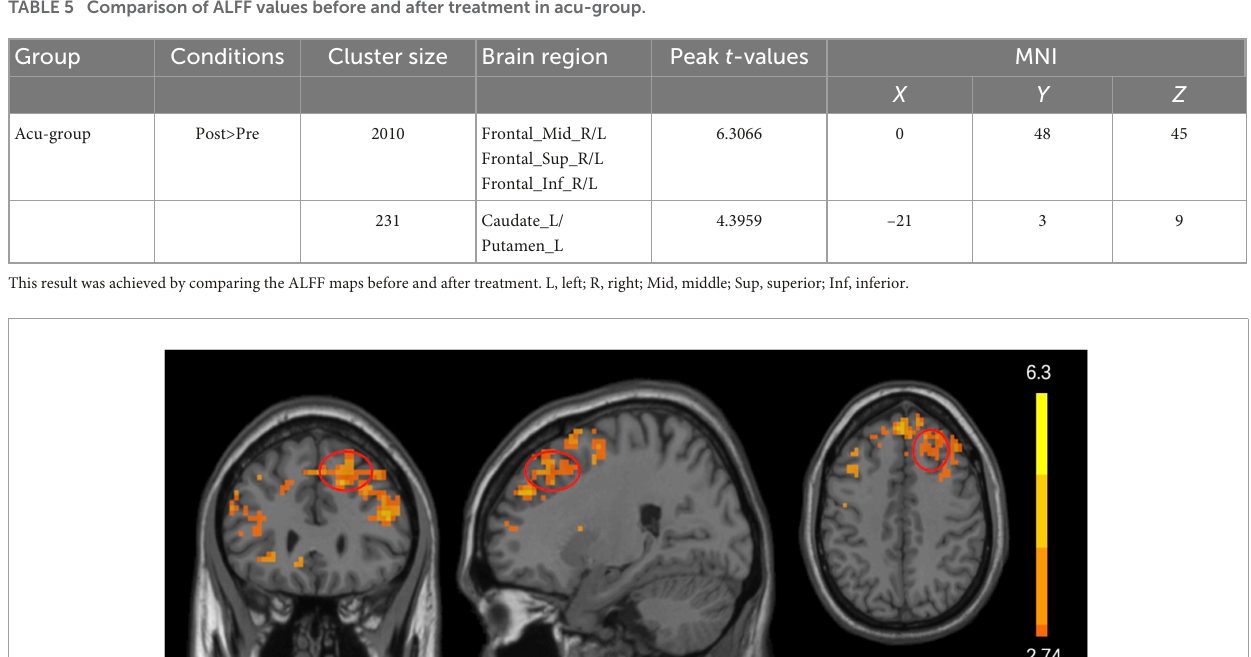
TABLE 5 Comparison of ALFF values before and after treatment in acu-group.